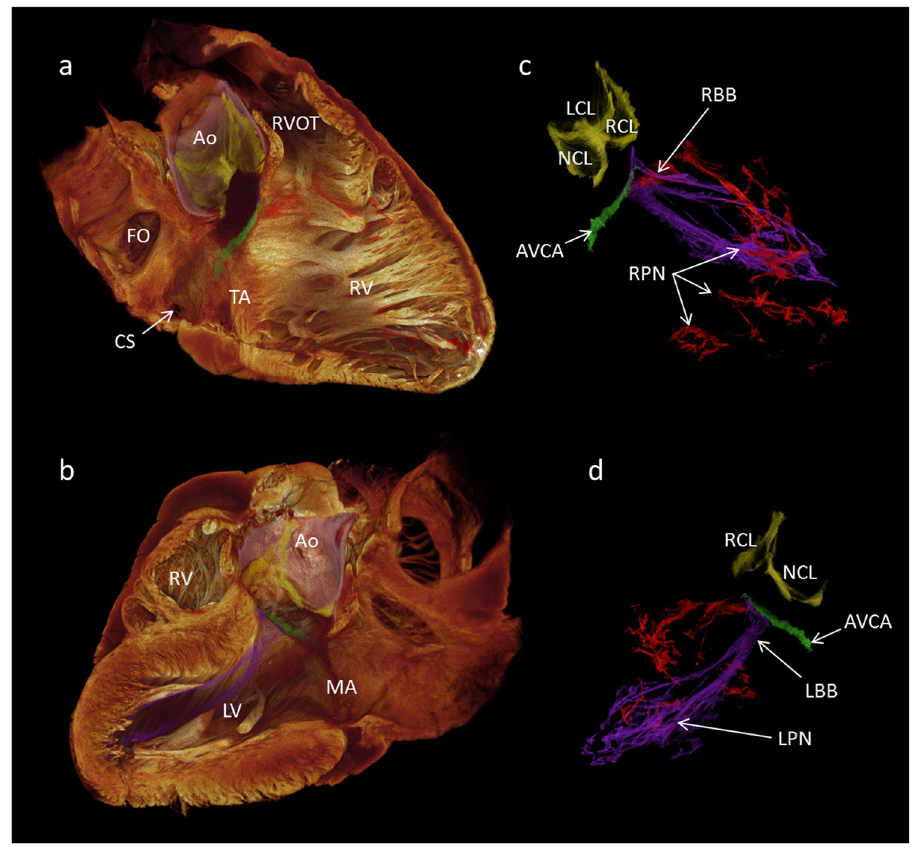
Figure 6. The 3D anatomy of cardiac conduction system in the intact human heart. This figure demonstrates high resolution (73 × 73 × 73 µ m 3 ) micro-CT data. From a single data set, the cardiac conduction system has been segmented ( c , d ) and overlaid on a semi-transparent or ‘ghosted’ rendering of the myocardium and great vessels ( a , b ). Panel (a) presents the view from the right side, and panel (b) from the left. The myocardium has been virtually sliced in the longitudinal axis to expose internal structures. Data is presented in the attitudinally correct position for the human, that is, in the upright posture. This 3D dataset is available in the supplementary material as a video (Supplementary Video S1) to demonstrate more clearly the insight that the dataset allows into the anatomical relations between the aortic root, the sinus node, the atrioventricular conduction axis, the atrial and ventricular septa and the bundle branches. Ao- aortic root, AVCA- atrioventricular conduction axis, CS- coronary sinus, FO- fossa ovale, LBB- left bundle branch, LCL- hinge of left coronary leaflet, LPN- left purkinje network, LV- left ventricle, MA- mitral annulus, NCL- hinge of non-coronary leaflet, RBB- right bundle branch, RCL- hinge of right coronary leaflet, RV- right ventricle, RVOT- right ventricular outflow tract, RPN – right Purkinje network, TA- tricuspid